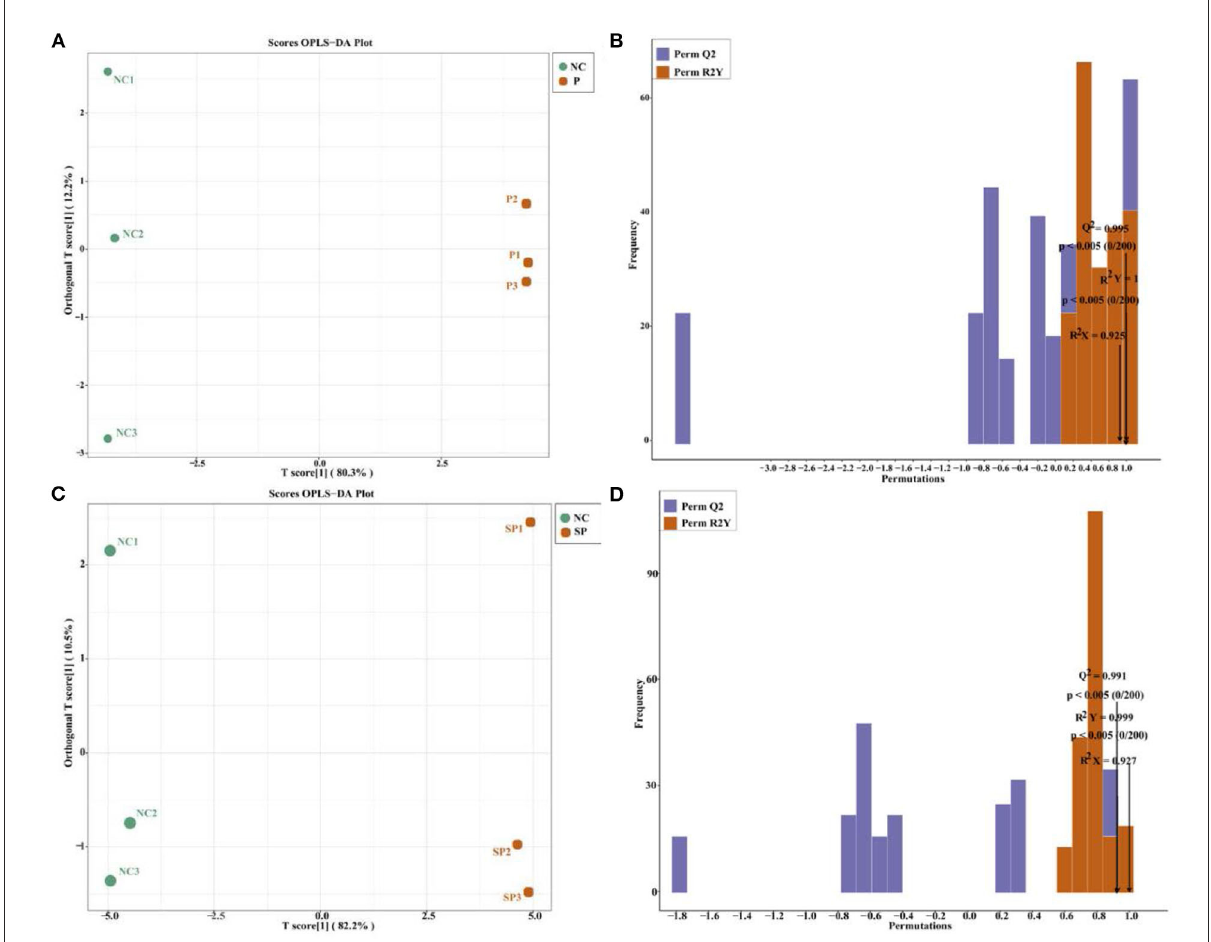
FIGURE5 The score graph and verification graph of the OPLS-DA model. (A) NC vs. P OPLS-DA model score graph; (B) NC vs. P OPLS-DA model validation graph; (C) NC vs. SP OPLS-DA model score graph; (D) NC vs. SP OPLS-DA model validation